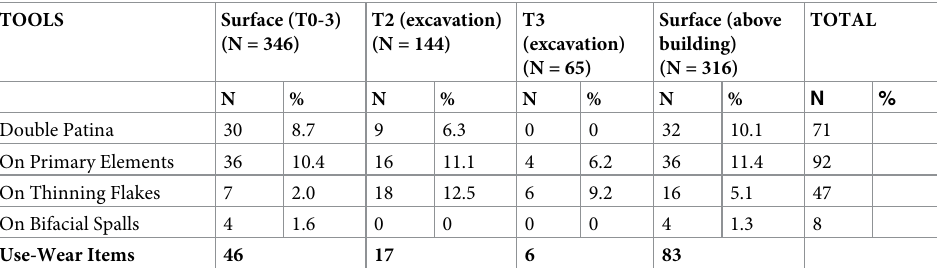
Table 8. Technological observations and double patina of tools—Kaizer Hill Terraces.